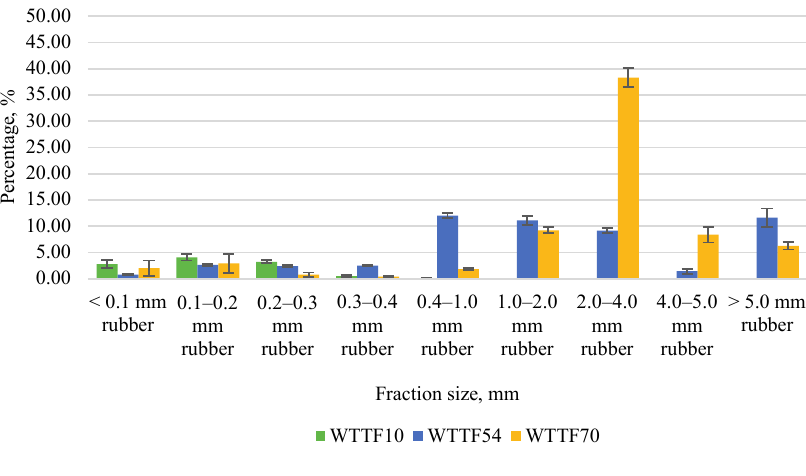
Fig. 2. Rubber granules impurities granulometry composition